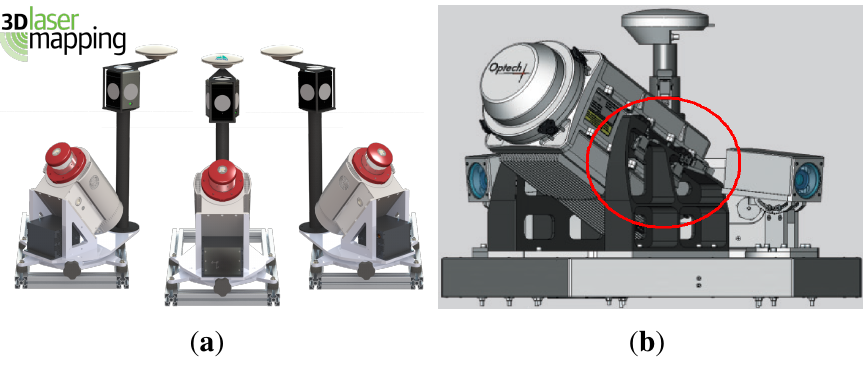
Figure 4. MMS adaptable sensor mountings: ( a ) adjustable horizontal rotation from 3D Laser Mapping, ( b ) adjustable vertical inclination from Optech